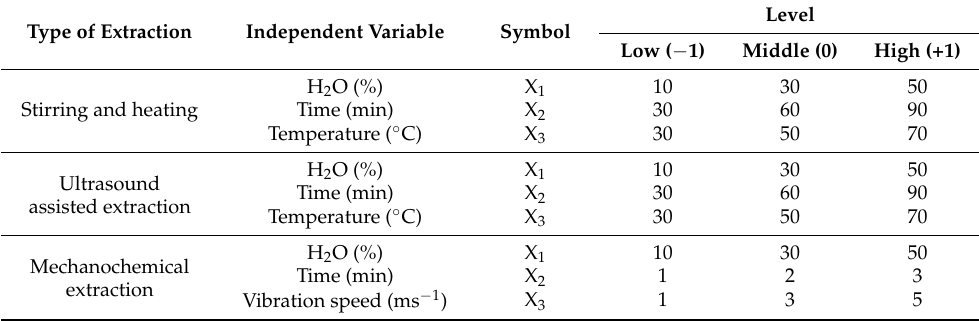
Table 5. Coded and real levels of independent variables for the designed